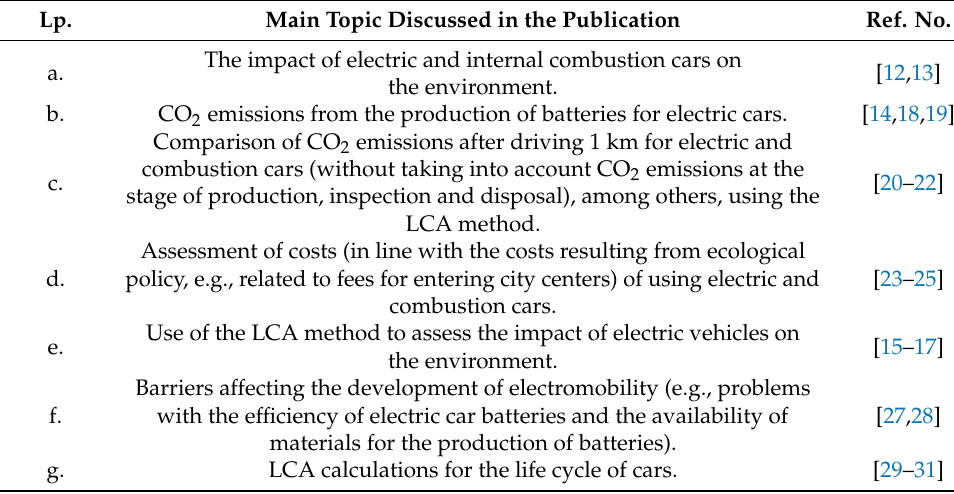
Table 1. Comparative analysis of existing